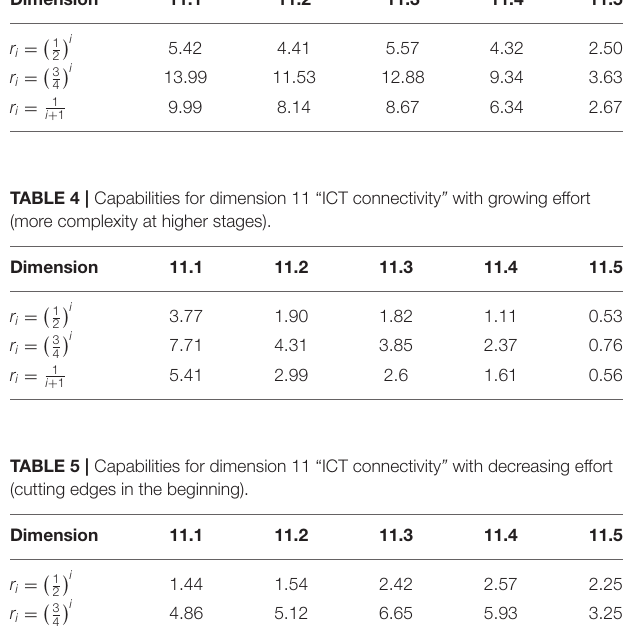
TABLE 3 | Capabilities for dimension 11 “ICT connectivity ” with different reduction factors. Dimension 11.1 11.2